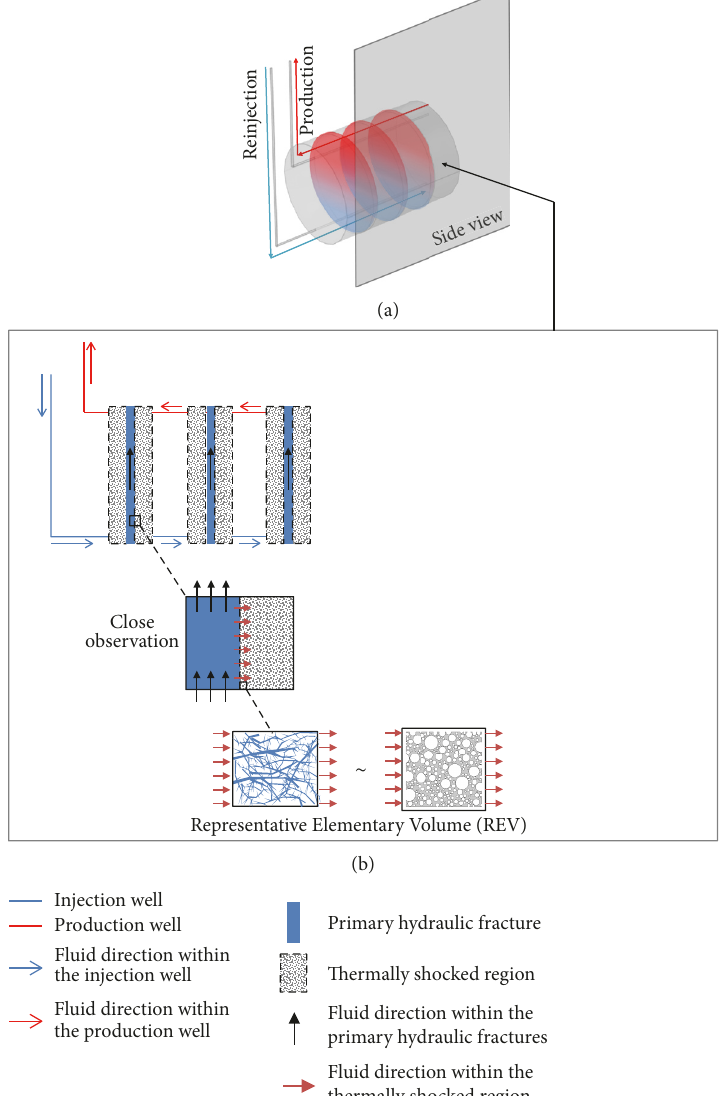
Figure 1: Conceptual model of EGS reservoir (a); side view of the model (b). The width of the hydraulic fractures and thermally shocked regions is exaggerated for